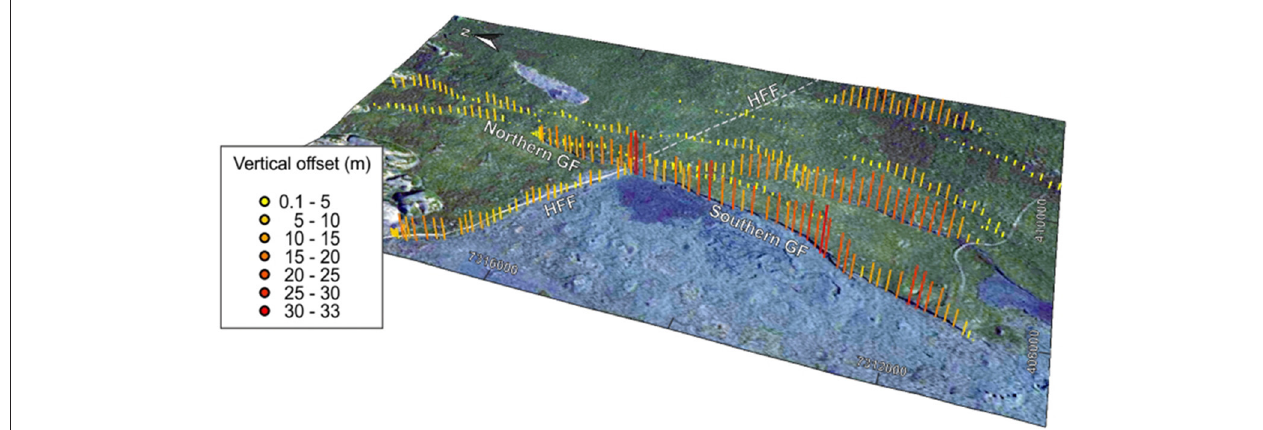
FIGURE 5 | Bar graphs summarizing the offsets cumulated along all the faults located north of the possible prolongation of the HFF with respect to those located south. The graph clearly indicates that those located to the south have much larger offsets.